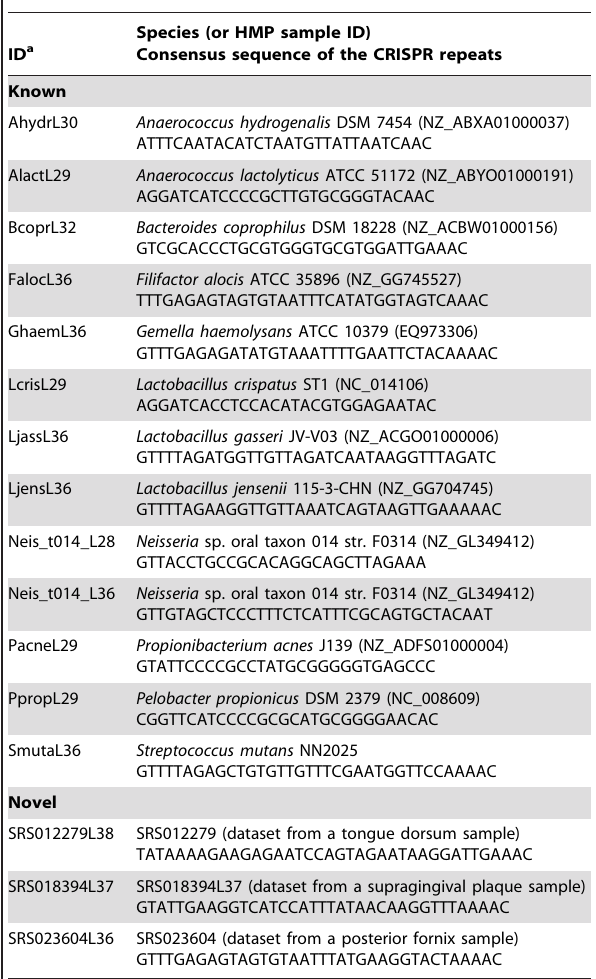
a The IDs of the CRISPRs are assigned using the following rules: 1) If a CRISPR ( e.g. , SmutaL36) is identified from a known complete/draft genome with species name (for SmutaL36, the genome is Streptococcus mutans NN2025), its ID uses five letters from the species name ( i.e. , Smuta) followed by the length of the repeats (length of 36 is shown as L36); 2) If a CRISPR (Neis_t014_L28) is identified from a known complete/draft genome that has only general